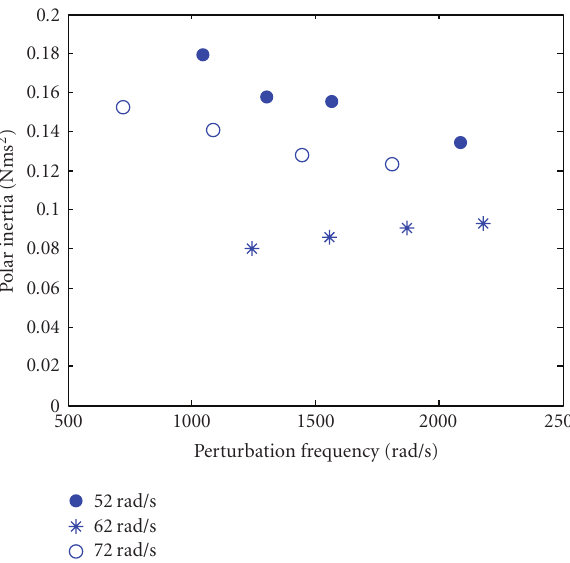
Figure 5: Additional polar inertia as a function of perturbing frequency and operating